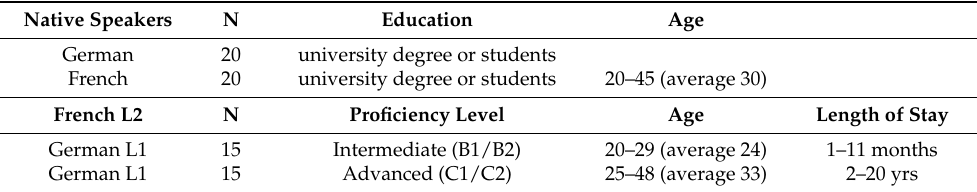
Table 1. The participants 4